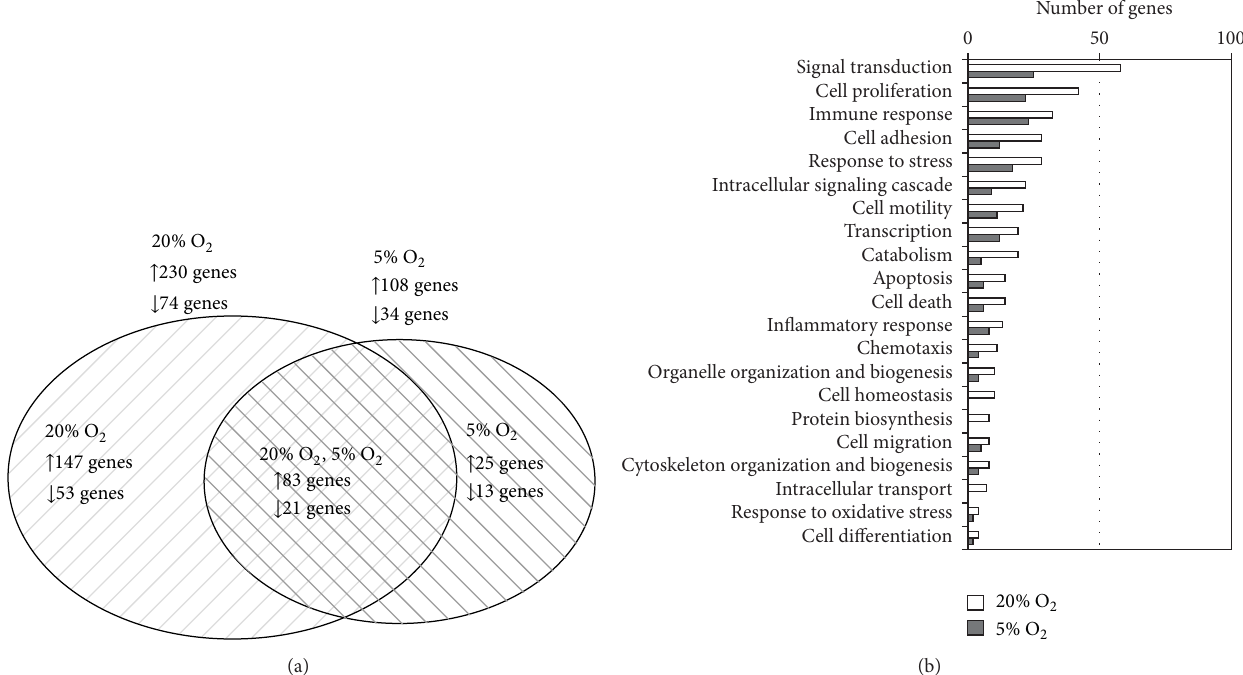
Figure 6: Characterisation of differential gene expression in ASCs after paracrine interaction with PHA-stimulated allogeneic PBMCs. (a) Venn diagram,showingthenumberofASCgenescommonlyordifferentiallyexpressedat20%and5%O 2 .(b)Thenumberofdifferentially expressed genes in Gene Ontology (GO) groups (biological